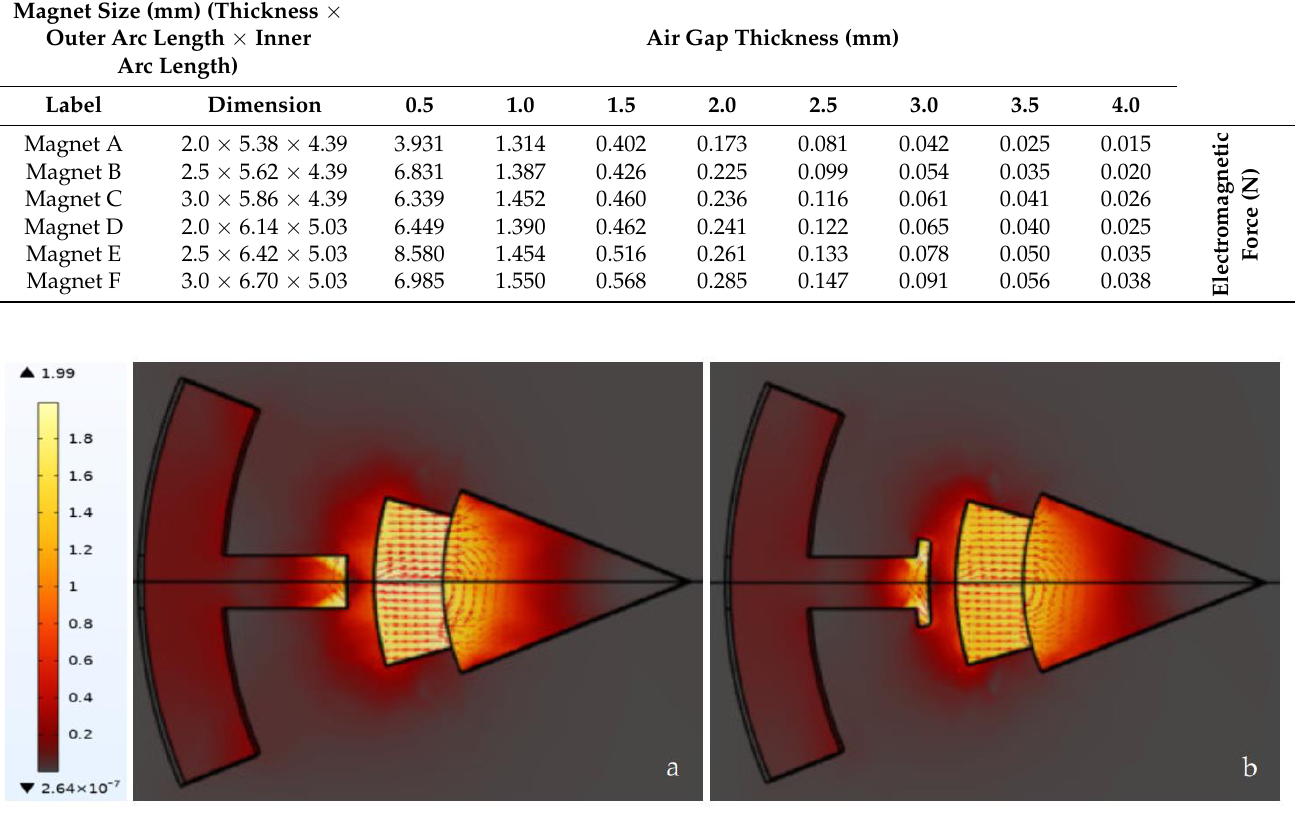
been plotted as shown in Figure 6. has